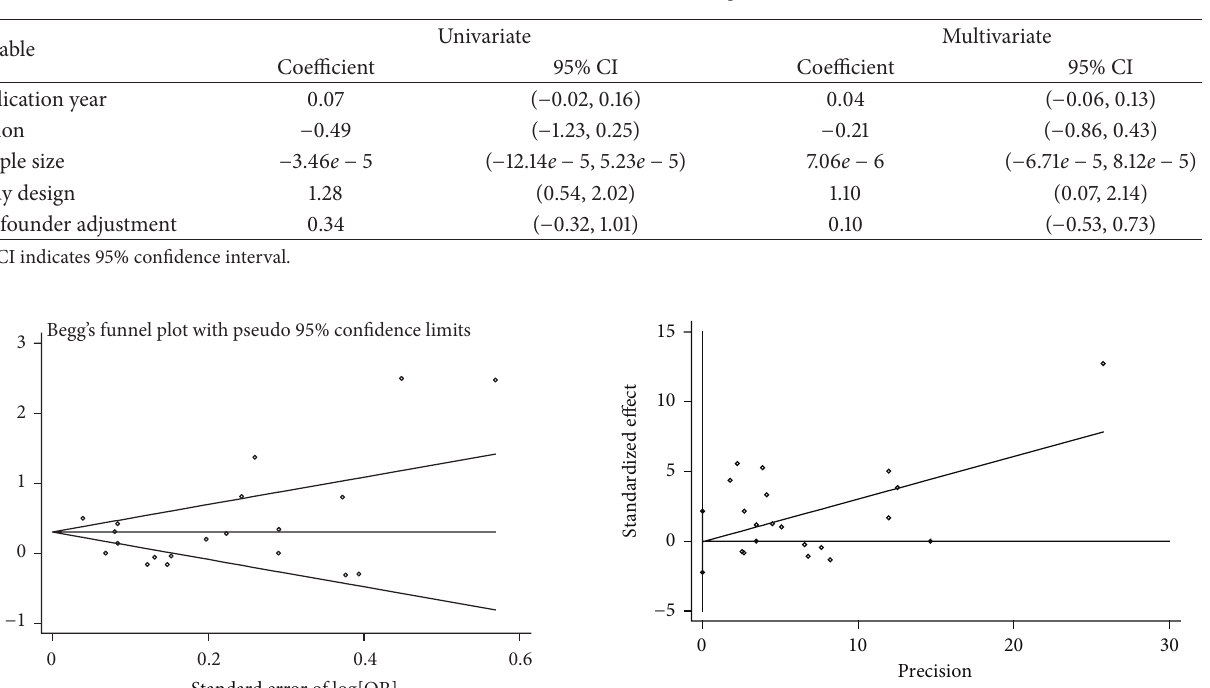
Table 2: Parameter estimation of meta-regression.